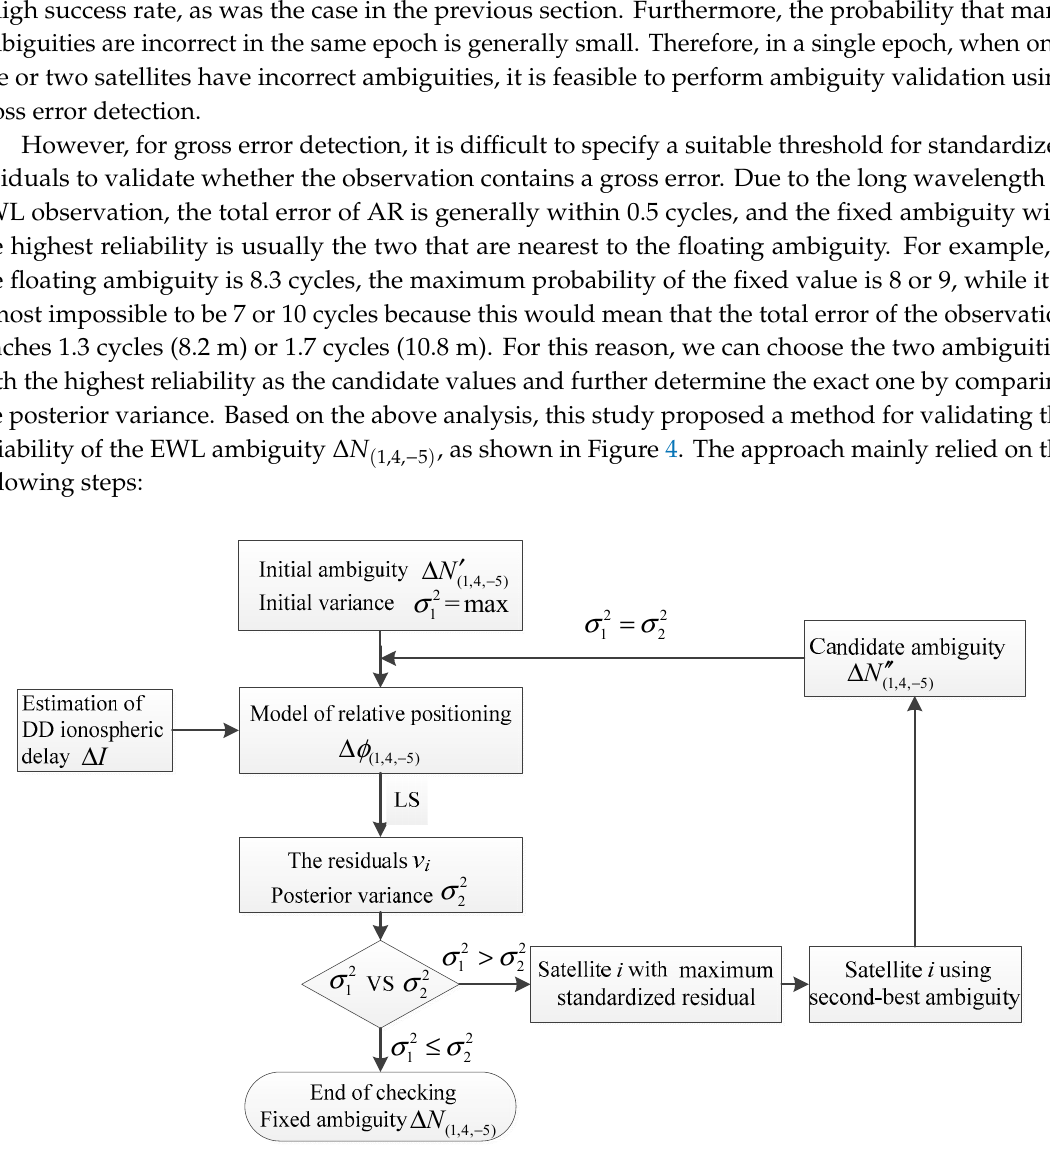
Figure 4. Method for validating the reliability of the EWL ambiguity Figure4. MethodforvalidatingthereliabilityoftheEWLambiguity ∆ N ( 1,4, − 5 ) . estimation.